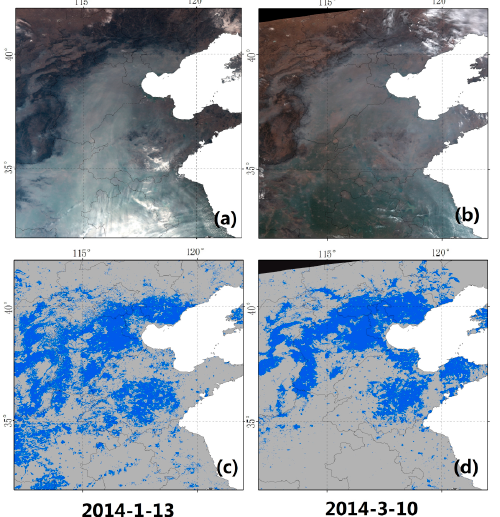
Figure 7. VIIRS true color image on 13 January 2014 ( a ) and 10 March 2014 ( b ) and the corresponding ephemeral water body test results ( c , d ) over the NCP. The ephemeral water body pixels are represented in blue.